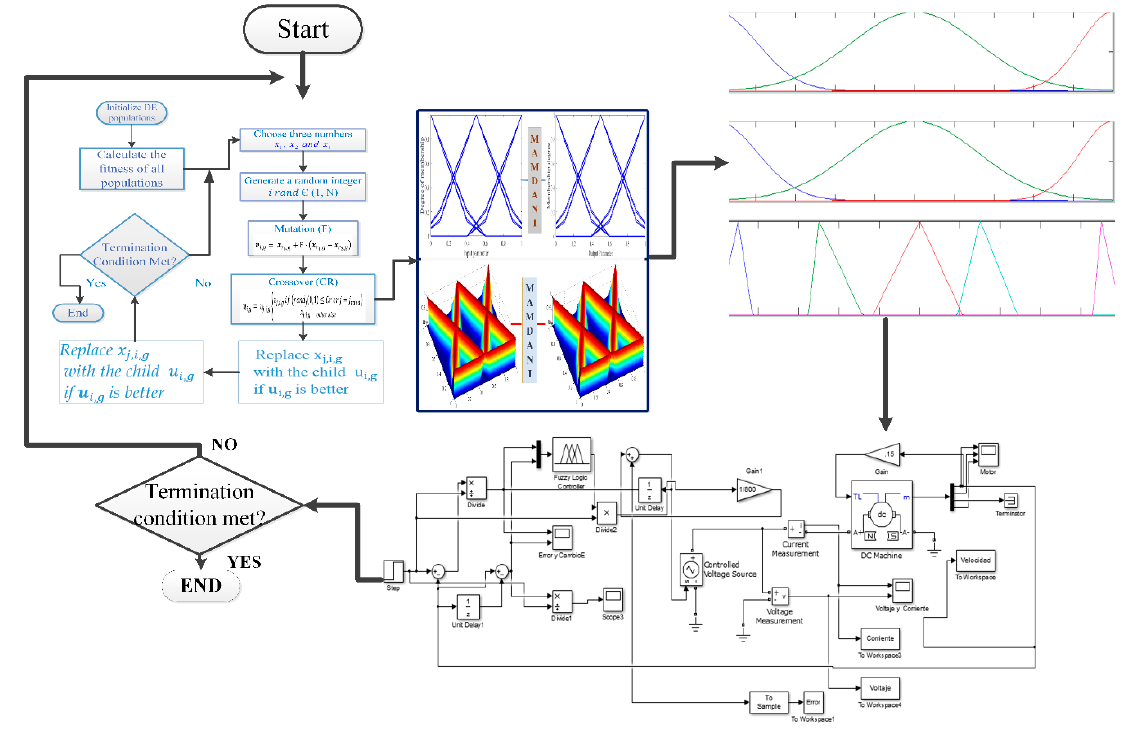
Figure 11. Structure of the experimentation process.